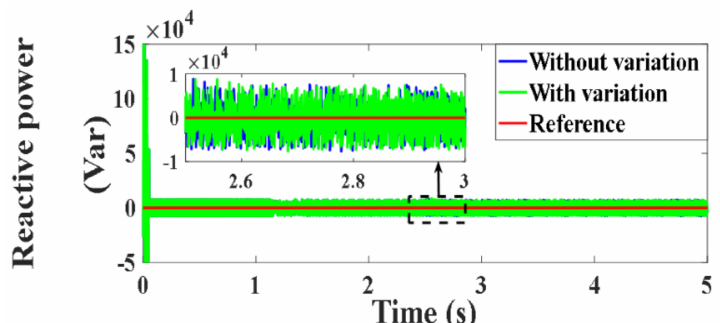
Figure 86. Reactive power under PVC (var).